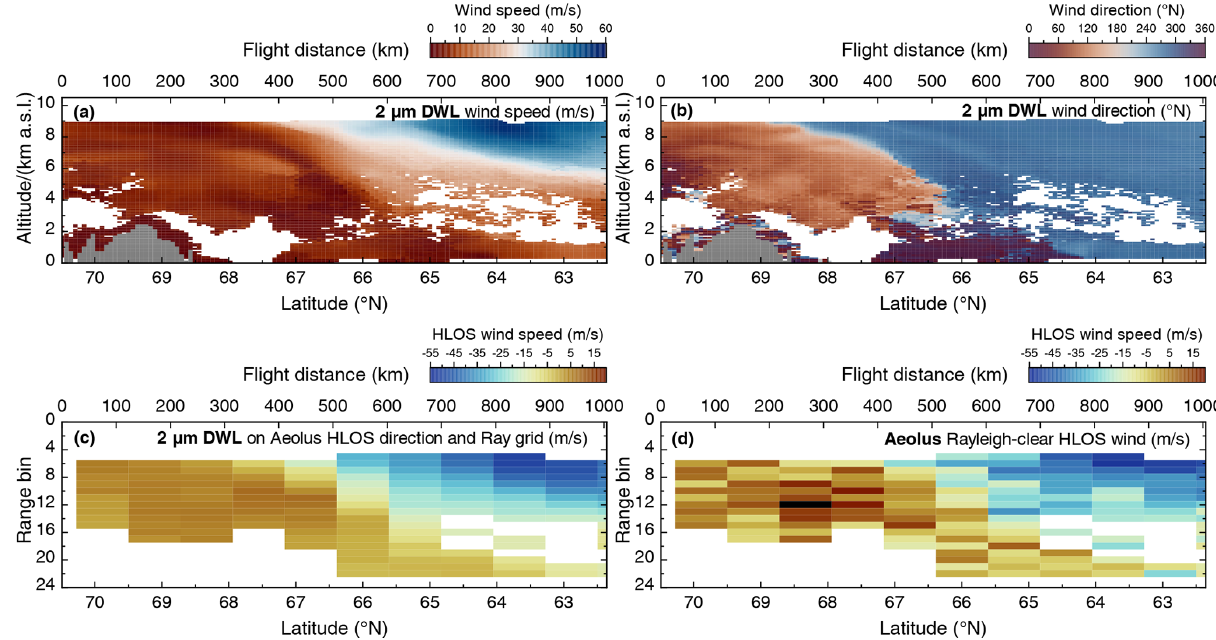
Figure 3. 2µmDWL wind speed (a) and wind direction (b) for the AVATAR-I underflight on 16 September 2019. The corresponding 2µmDWL data projection onto the Aeolus HLOS direction is shown in panel (c) , and the Aeolus HLOS Rayleigh winds are shown in panel (d) . White fields indicate missing